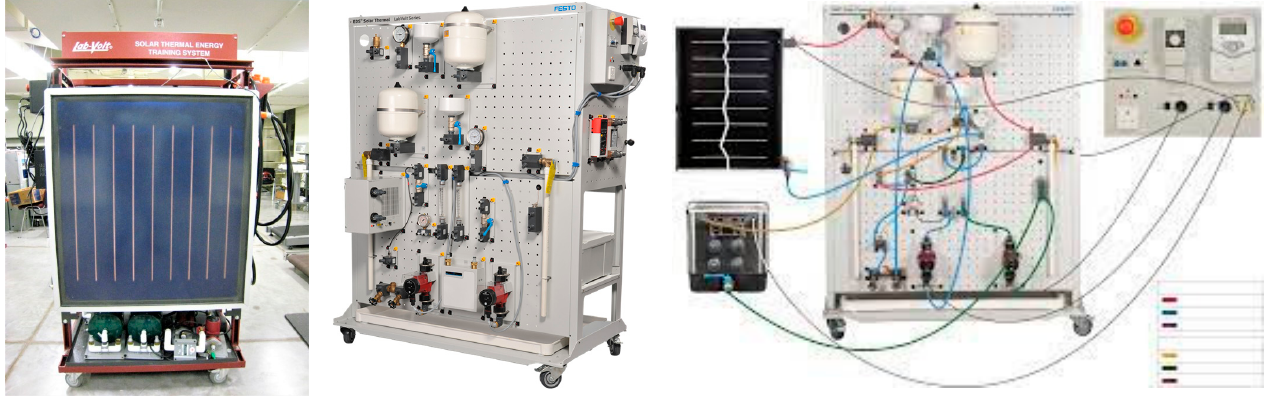
Figure 6. Different LabVolt solar thermal energy collectors [2].